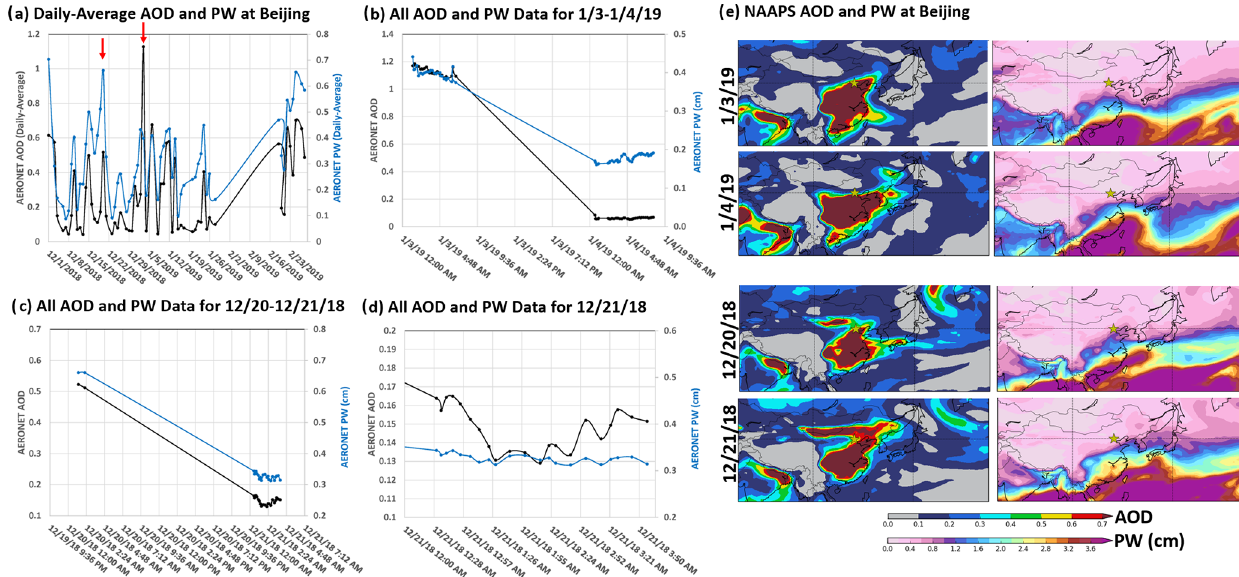
Figure 16. AOD and PW time series at the Beijing site, China, in which strong positive correlations are observed during the DJF season. The daily-average AOD and PW time series are shown for the 2018–2019 DJF season, with red arrows indicating select events for which joint peaks in AOD and PW are observed (a) . Time series of AERONET data (non-averaged, all data) for dates identified with red arrows are shown in time series (b–d) . Additionally, NAAPS-RA AOD and PW (cm) fields are shown for the same dates, with the AERONET site marked with a yellow star (e) , including the air mass movement for 3–4 January 2019 and 20–21 December 2018.